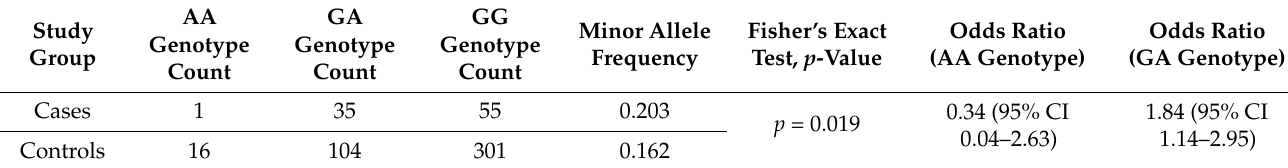
Table 1. Summary statistics of the variant rs3825942 in the gene LOXL1 , which showed statistical significance. Study